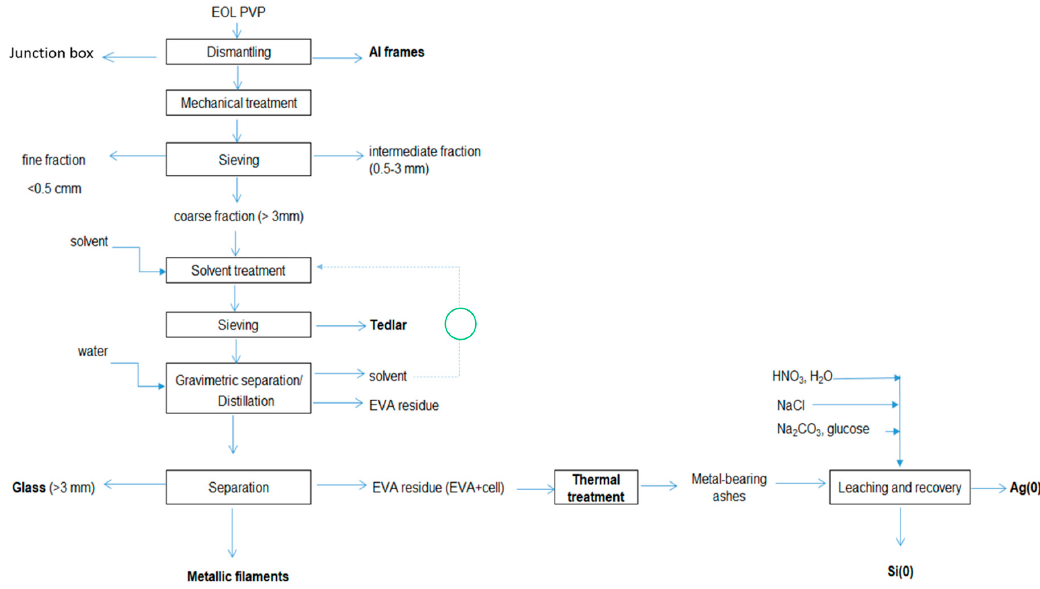
Figure 5. Block diagram of the advanced PhotoLife process.